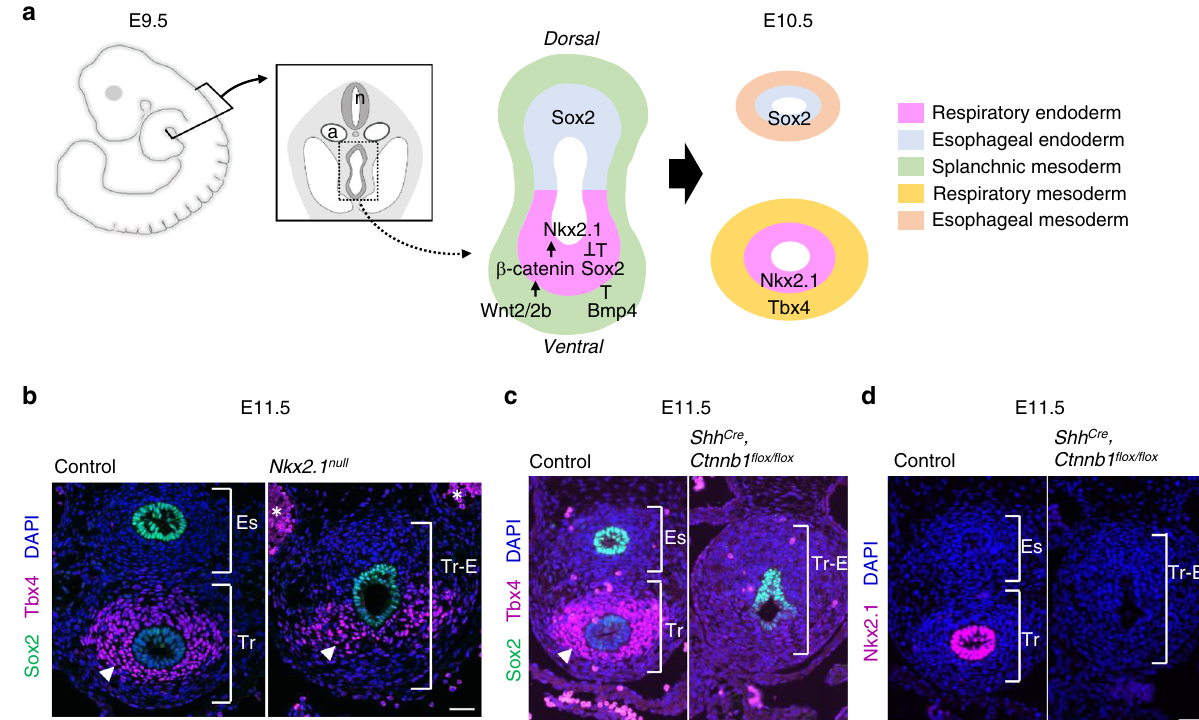
Fig. 1 Activation of Wnt signaling in endoderm, but not Nkx2.1 expression, is activated to promote mesodermal development of the mouse trachea. a Schematic model of tracheoesophageal segregation. b Transverse sections of Nkx2.1 null mouse embryos and littermate controls. Sections were stained for Sox2 ( green ), Tbx4 ( magenta ), and DAPI ( blue ). Arrowheads indicate Tbx4 + tracheal mesoderm. Asterisks indicate nonspeci fi c background signal of blood cells in dorsal aorta. n = 3/3 embryos per genotype. c Transverse sections of Shh Cre , Ctnnb1 fl ox/ fl ox mouse embryos and littermate controls. Sections were stained by Sox2 ( green ), Tbx4 ( magenta ), and DAPI ( blue ). Arrowheads indicate Tbx4 + tracheal mesoderm. n = 3/3 embryos per genotype. d Transverse sections of Shh Cre , Ctnnb1 fl ox/ fl ox mouse embryos-, and littermate controls. Sections were stained by Nkx2.1 ( magenta ) and DAPI ( blue ). n = 3/3 embryos per genotype. n neural tube, a aorta, Es Esophagus, Tr Trachea, Tr – E Trachea – Esophageal tube. Scale bar, 40 μ